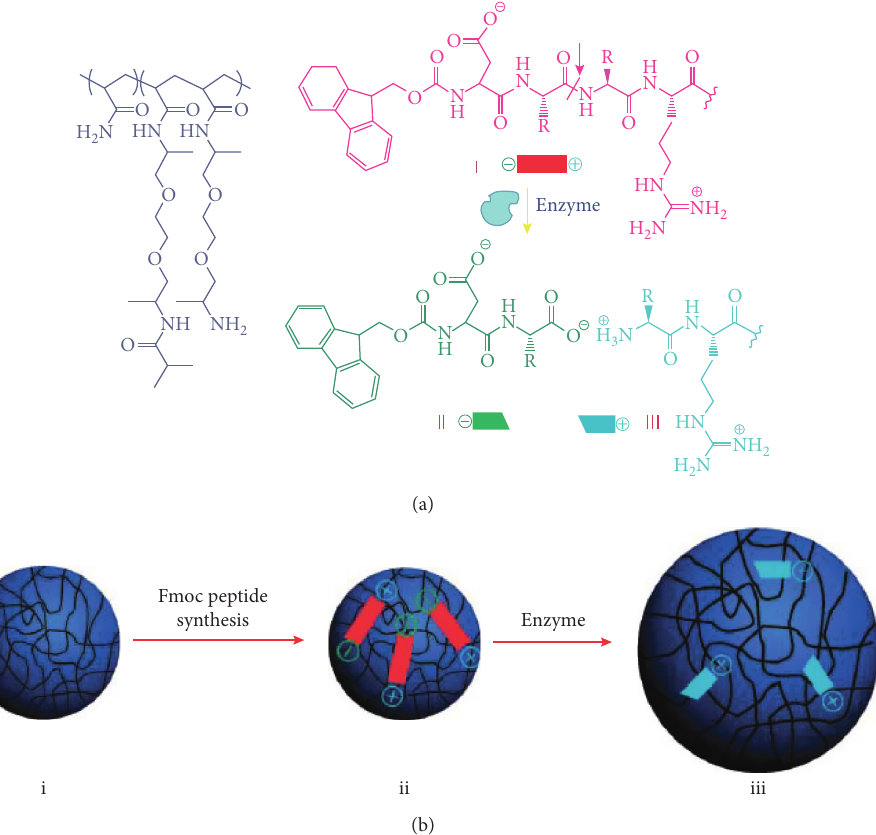
Figure 5: Schematic illustration of enzymatic hydrogel synthesis technique. (a) PEGA and peptide sequence conjugated onto microparticles and enzyme cleaved product and (b) PEGA hydrogel) (adapted from [34]).